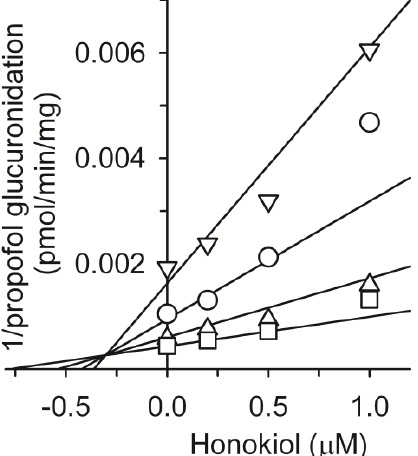
Figure 3. Representative Dixon plots for the inhibitory effects of honokiol on UGT1A9-catalyzed propofol glucuronidation in pooled human liver microsomes (H161). Each symbol represents the substrate concentration: propofol, 5 μ M ( ▽ ), 10 μ M (  ), 20 μ M (  ), 40 μ M (  ). Each data point represents the mean of triplicate experiments.